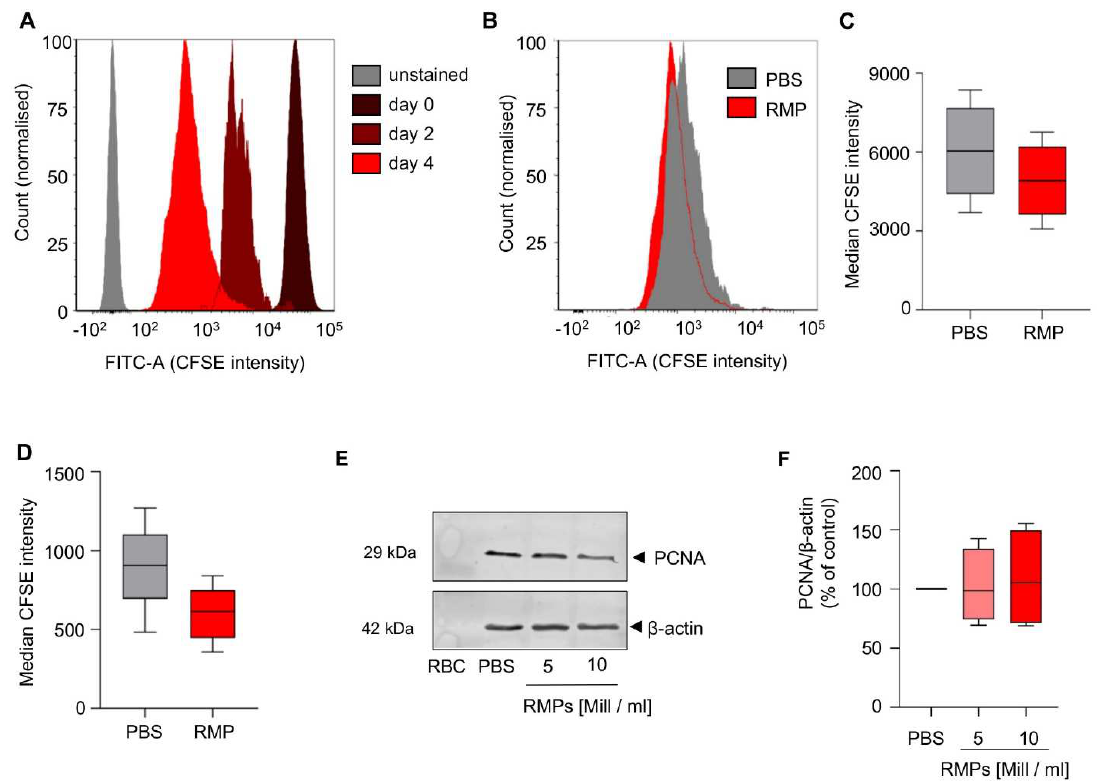
Figure 3. Influence of red blood cell-derived microparticles on the proliferation of HCT-116 cells. ( A – D ) HCT116 cells were stained with carboxyfluorescein succinimidyl ester (CFSE) and incubated with 5 × 10 6 red blood cell-derived microparticles (RMPs)/mL or vehicle control (phosphate buffered saline = PBS). After two and four days, CFSE intensity was measured using flow cytometry (Fluo- rescein isothiocyanate-A (FITC-A) channel). ( A ) Data shows the intensity of CFSE on day 0, day 2 and day 4 of one representative experiment (RMP treated cells), with unstained cells as negative control. ( B ) Overlay of the intensity of CFSE on day four of one representative experiment comparing RMP-treated cells and vehicle control. ( C , D ) Data represents median, 25th to 75th percentile (box), minimum to maximum (whiskers) of RMP treated cells versus vehicle control on day two ( C ) and four ( D ) of five independent experiments ( n = 5). ( E , F ) HCT-116 cells were incubated with the indicated RMP concentrations or vehicle control. After 24 h, cells were lysed and PCNA (proliferat- ing cell nuclear antigen) levels were assessed by Western blot analysis. β-actin served as loading control. Lysed red blood cells (RBCs) were used as negative control. ( E ) Shown is one representative Western Blot out of four independent experiments. ( F ) Quantification of PCNA expression after normalization to loading control ( n = 4). Data represents median, 25th to 75th percentile (box), min- imum to maximum (whiskers) versus vehicle control.